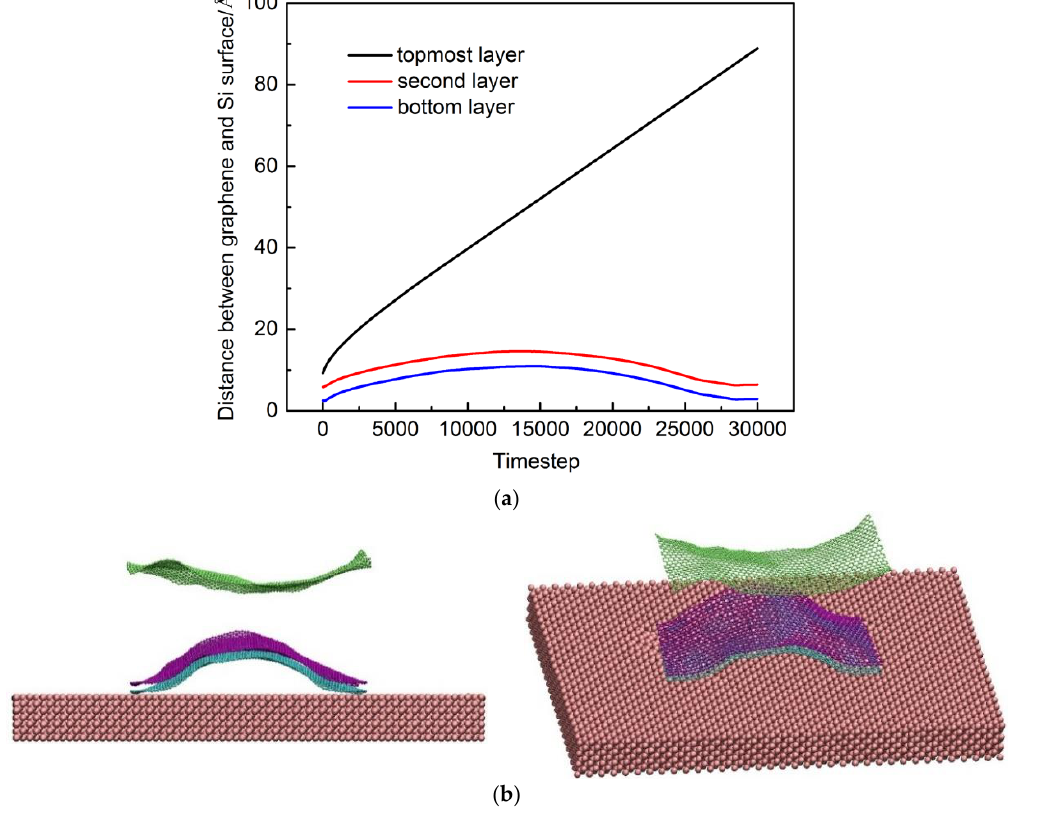
Figure 5. Adhesion behavior in a three-layer graphene system, when the vertical upward velocity is 10.16 Å /ps: ( a ) The variation of distance between graphene and the Si substrate surface with timestep; ( b ) atomic trajectory of the three-layer graphene system.